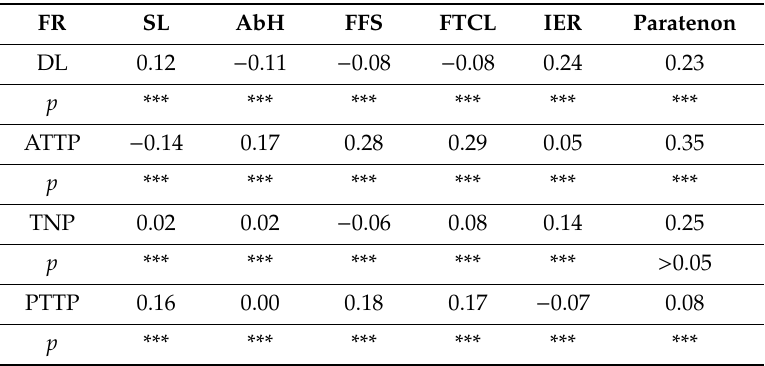
Table 2. Coexistence of connections between FR and PTTP, TNP, ATTP and its correlation with the interconnection between FR with SL, AbH, FFS, FTCL, IER, and paratenon. FR